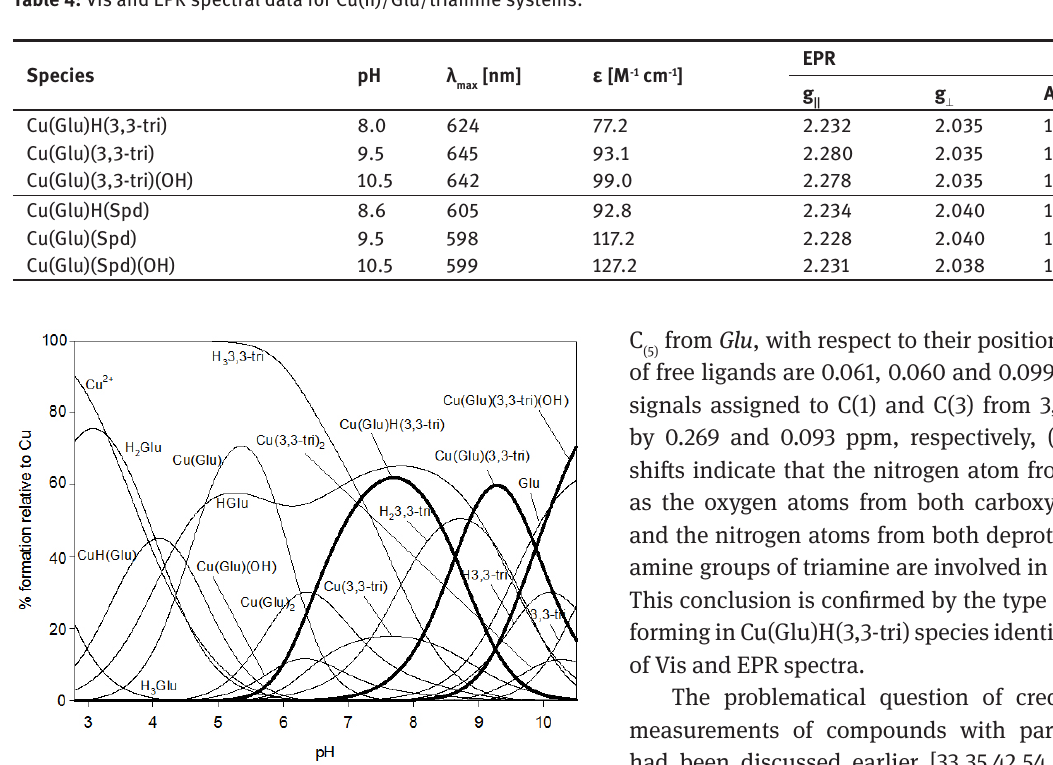
=5.4×10 -4 M; Cu2+ ). 3